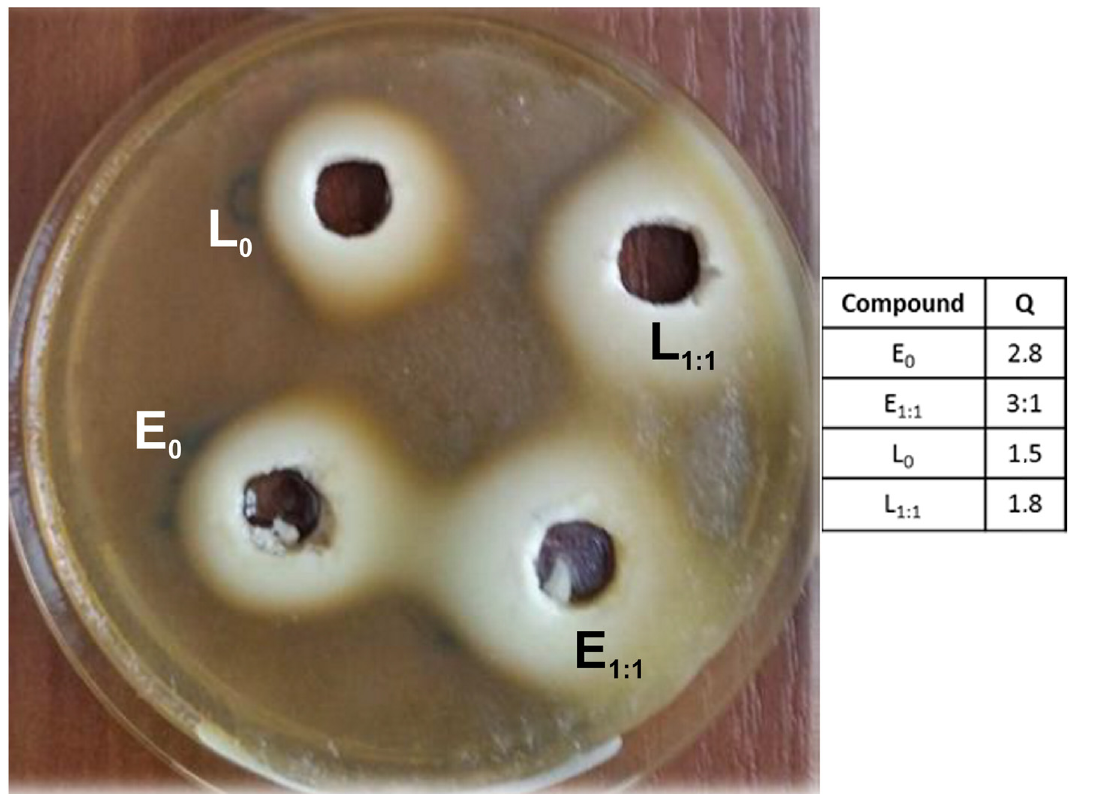
Figure 8. Aeromonas hydrophila growth inhibition zones induced by linalool and eugenol: eugenol, E 0 ; linalool, L 0 —not diluted; eugenol, E 1:1 ; linalool, L 1:1 —diluted with water in a ratio of 1:1.